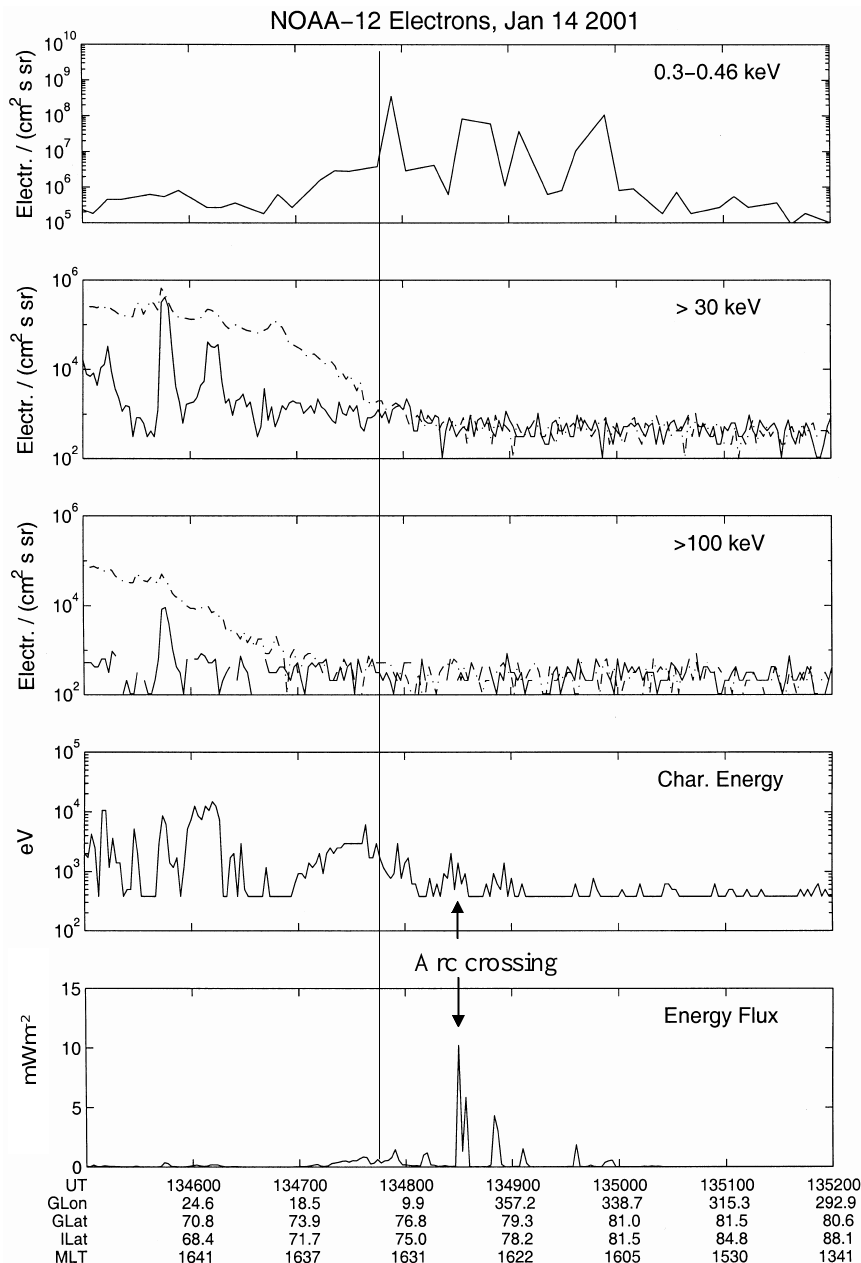
Fig. 8. NOAA-12 electron particle ob- servations along the path indicated by the straight red line west of Svalbard in the 13:48:10 and 13:49:10UT frames in Fig. 4 (bottom row). The upper panel shows the integral of downward moving electrons over the energy range 0.30– 0.46keV. The second and third panels from the top represent the integral flux over 30–1000keV and 100–1000keV for electrons. The solid line is the flux measured along the zenith direc- tion, and the dot-dashed line is the flux perpendicular to the zenith. The two bottom panels give characteristic en- ergy and energy flux for the electron